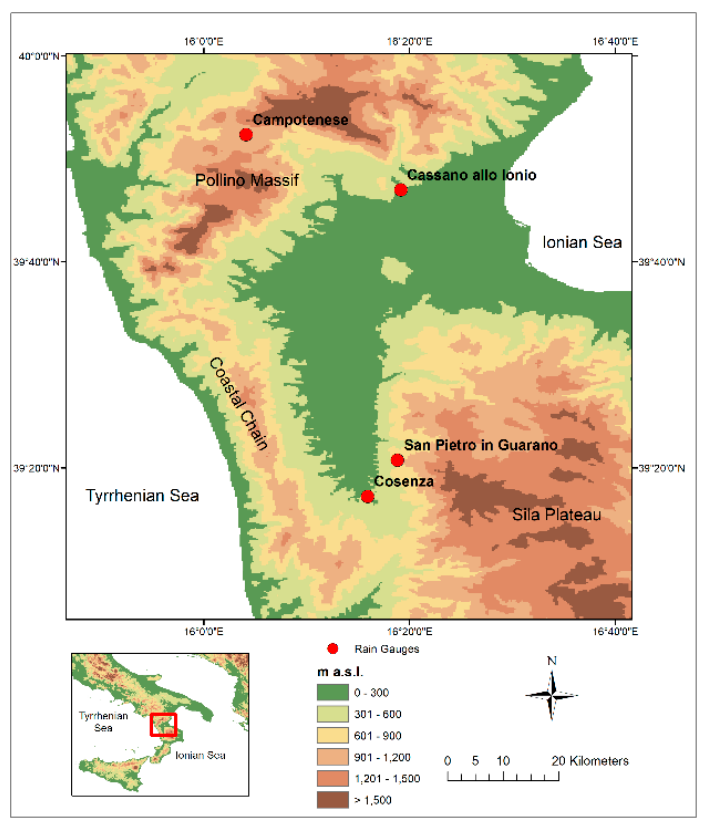
Figure 2. Localization of the rain gauges on a Digital Elevation Model of the Calabria region.